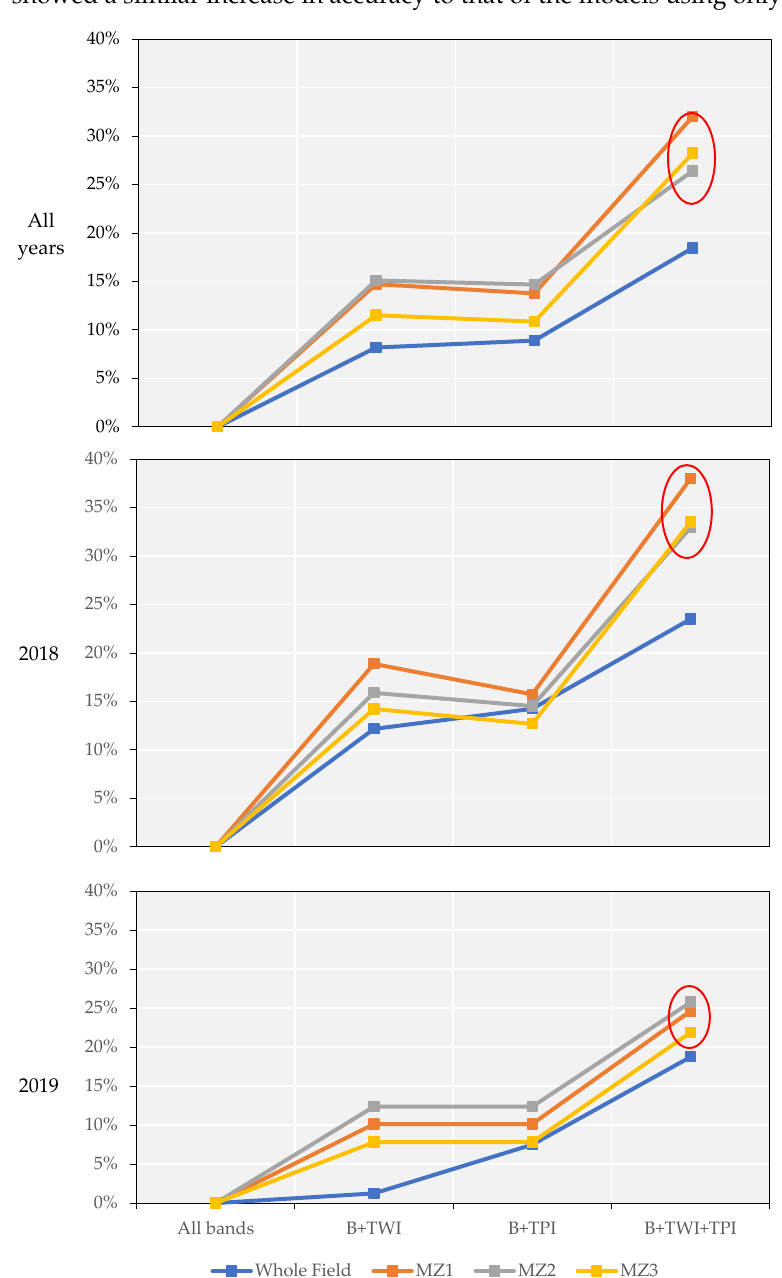
Figure 8. Accuracy (MAE) of the validation phase of the model developed using whole-field data in three scenarios (2018, 2019, and all years combined); the accuracy is showed in each management zone. TWI: topographic wetness index; TPI: topographic position index; MZ1, MZ2, and MZ3: man- agement zones one (high yield), two (low yield), and three (intermedium yield), respectively. To determine whether the association between topographical indices and spectral bands could increase the accuracy of the yield forecasting, we calculated the relative error of the models when only spectral bands were used as features (Figure 9). Analyzing all scenarios, isolated seasons (2018 and 2019), and combined seasons, including spectral bands + TWI + TPI as features, the models obtained a better accuracy, whereas accuracy was higher for site-specific models (Figure 8). For the scenario of the isolated season and site-specific models, the models using spectral bands + TWI and spectral bands + TPI showed a similar increase in accuracy to that of the models using only spectral bands.